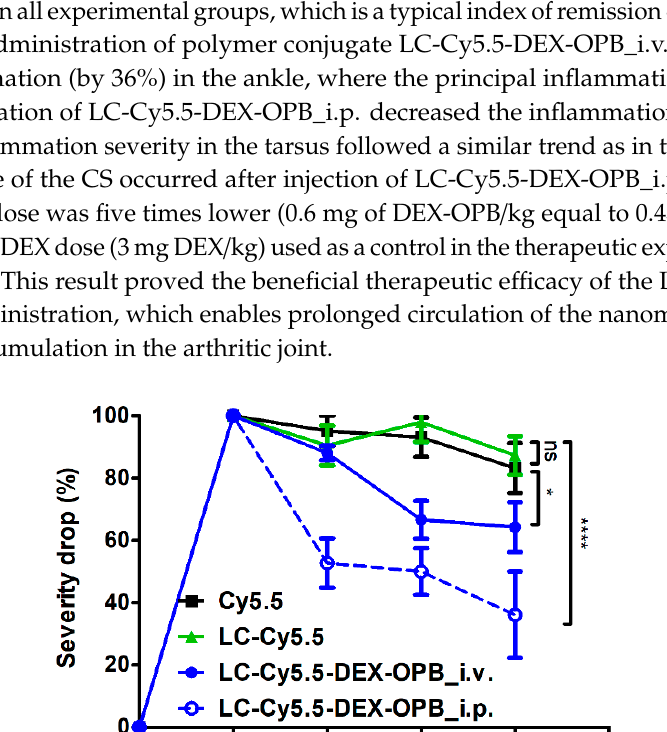
Figure 6. Ex vivo biodistribution of Cy5.5, LC-Cy5.5, and LC-Cy5.5-DEX-OPB injected i.v. or i.p. The ratio tissue/left paw is normalized to the weight of the given tissue. Injection of the 0.1 mg Cy5.5 eq/kg, n =